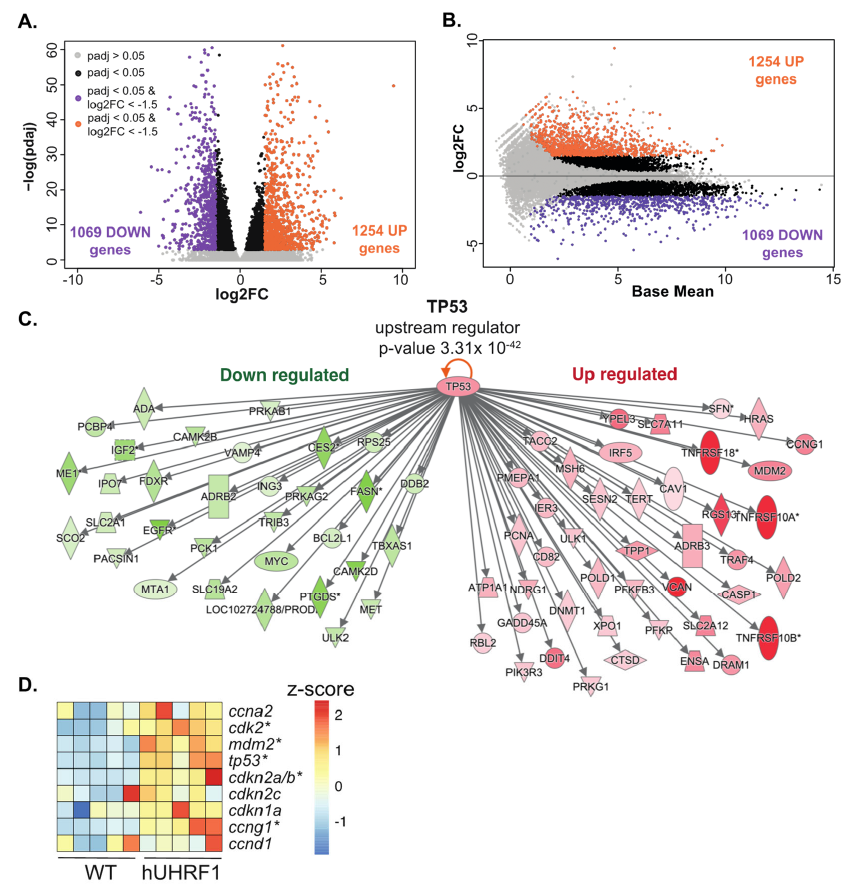
Figure 1. hUHRF1 overexpression in zebra fi sh hepatocytes activates Tp53. Bulk RNAseq analysis of 5 pools of livers collected from hUHRF1 larvae normalized to WT siblings on 5 dpf. ( A ) Volcano plot and ( B ) MA plot showing log2 fold change and log2 p -value adjusted of hUHRF1 overexpressing livers compared to WT siblings. Genes with p -value adjusted greater than 0.05 are shown in grey, signi fi cant DEGs ( p -value adjusted smaller than 0.05) are in black, upregulated DEGs ( p -value adjusted smaller than 0.05 and log2 fold change greater than 1.5) are in purple and downregulated DEGs ( p -value adjusted smaller than 0.05 and log2 fold change smaller than − 1.5) are in orange. ( C ) IPA analysis identi fi ed tp53 as a top upstream regulator of the transcriptomic changes in hUHRF1 livers ( p -value 3.31 × 10 -42 ). Direct TP53 target genes predicted to be downregulated following Tp53 activation and that are downregulated in hUHRF1 overexpressing livers dataset are shown in green, and direct targets are predicted to be upregulated following TP53 activation and that are upregulated in hUHRF1 overexpressing livers. ( D ) Heatmap of the expression of TP53 direct target genes in hUHRF1 overexpressing livers compared to WT siblings at 5 dpf. Z-score is calculated on raw